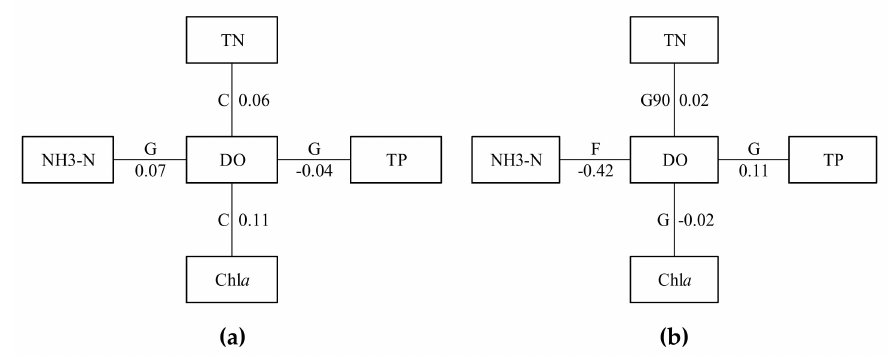
Figure 3. Structures of C-vine Tree 1, where C—Clayton copula, F—Frank copula, G—Gaussian